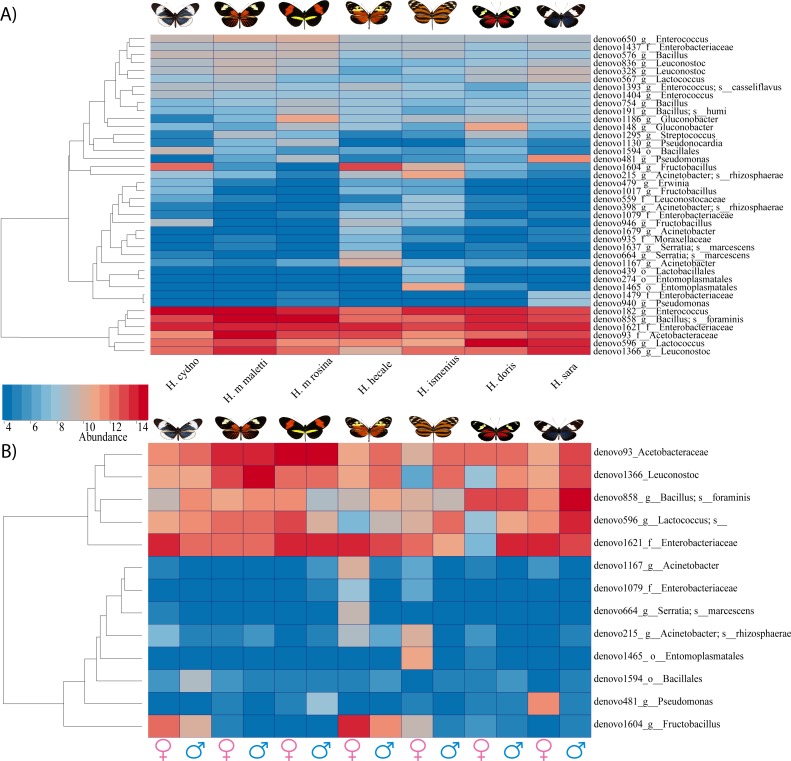
Bacterial significant differences between species, subspecies and sexes.(A) A heatmap of reads found per butterfly of the 40 OTUs which differed in abundance between species based on G-test with Bonferroni corrected p-values. (B) Plot abundance of the 13 bacteria found to differ between males compared to females (all species pooled)